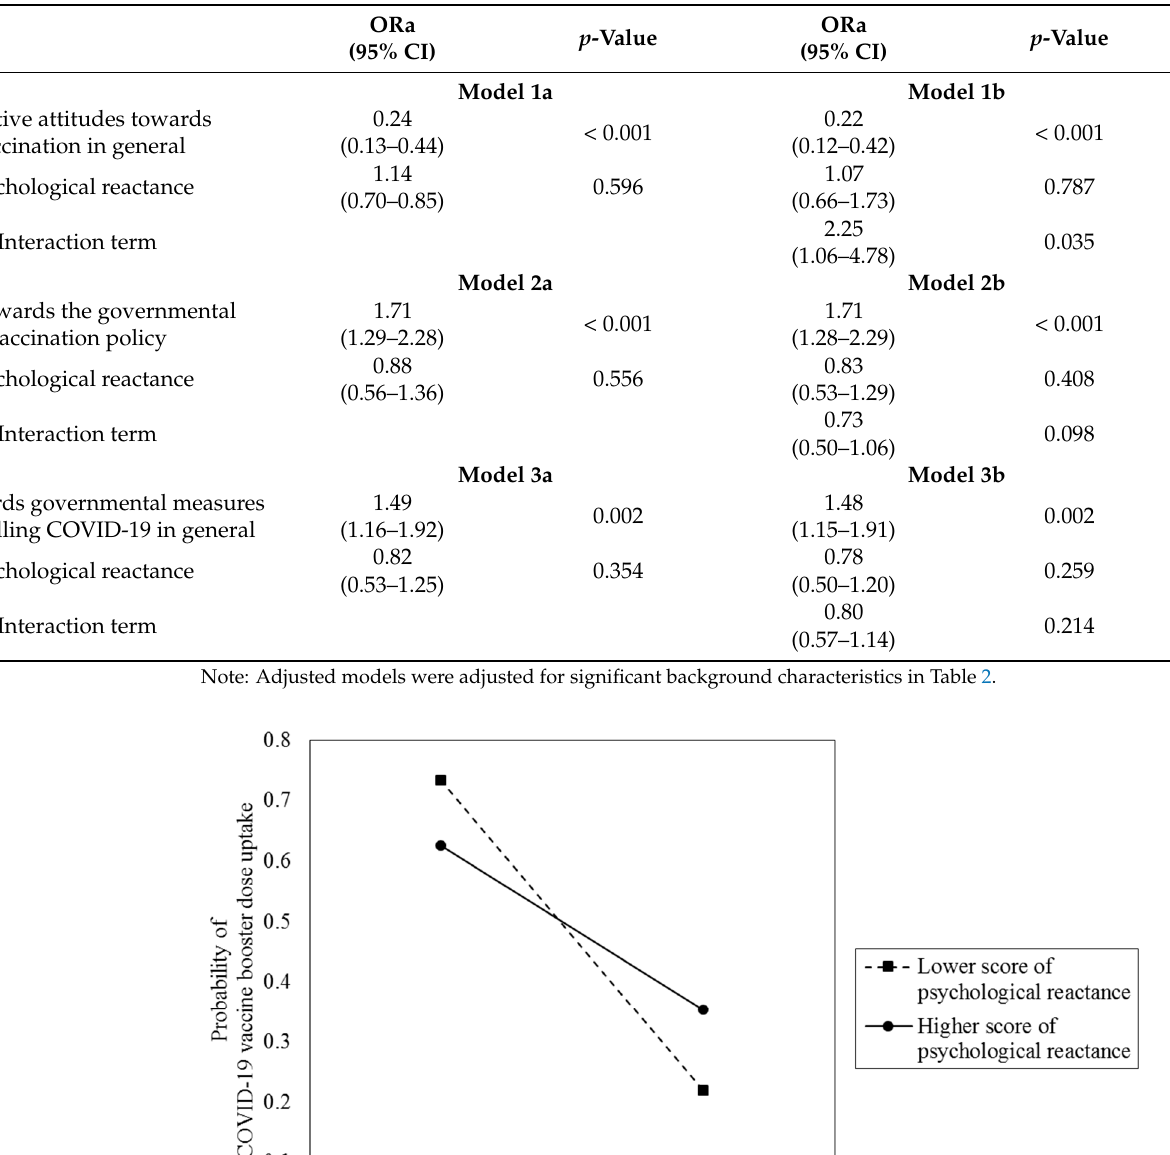
Table 4. Hierarchical regression analysis predicting uptake of a booster dose ( n = 264).